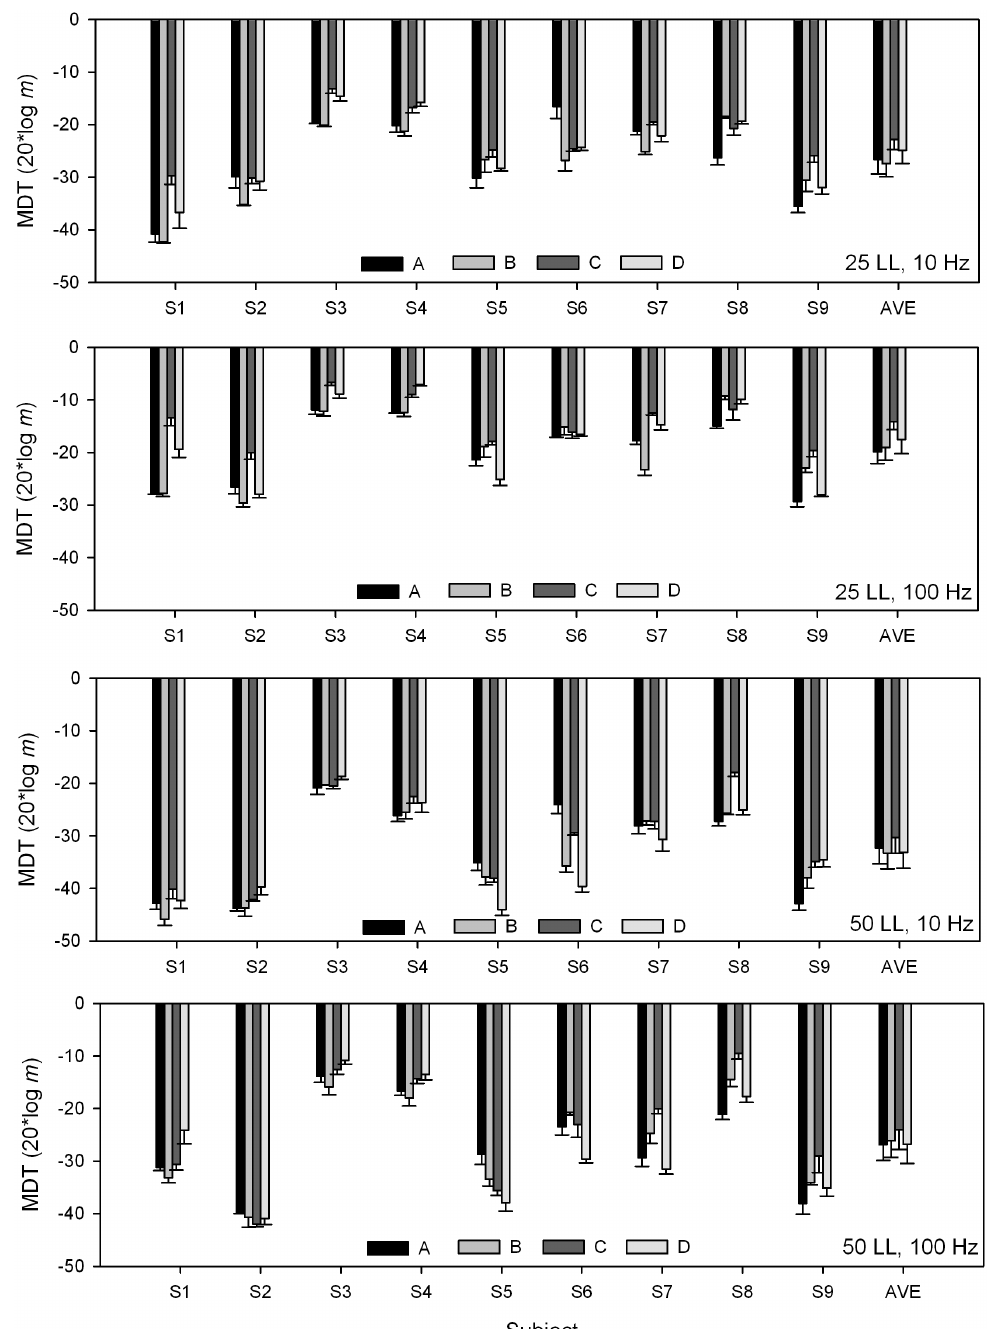
channel assignments are shown for each subject in Table 1. The error bars show the standard error.